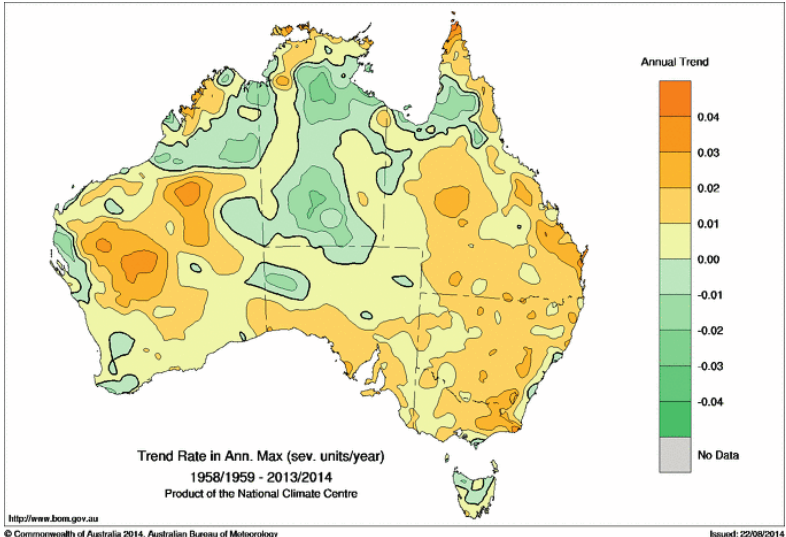
Figure 13. As per Figure 12 but in severity units per